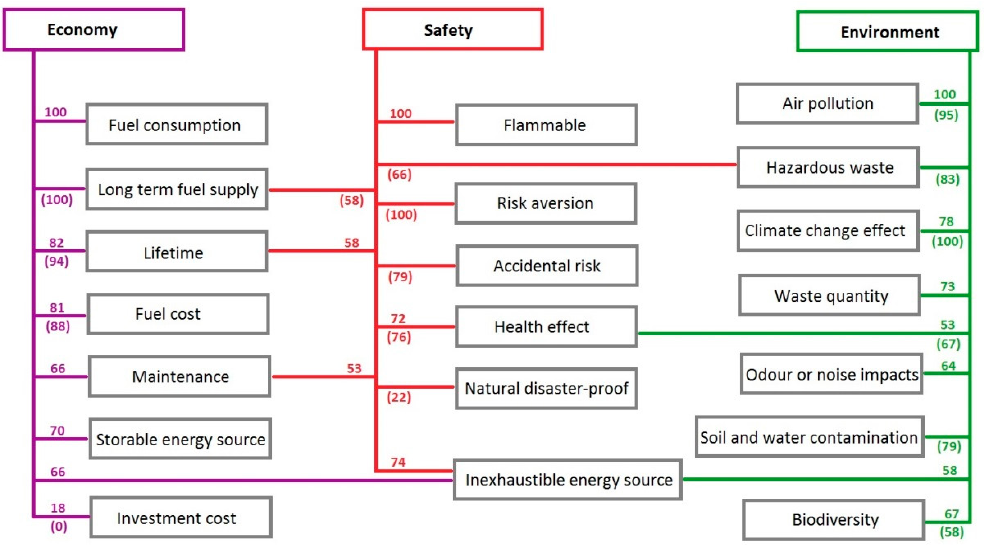
Figure 2. The system of sub-criteria under three main criteria with assigned importance weights, in a 0–100 scale until the limit of K i , for the heating and electricity sector (values for the electricity sector are provided in brackets).